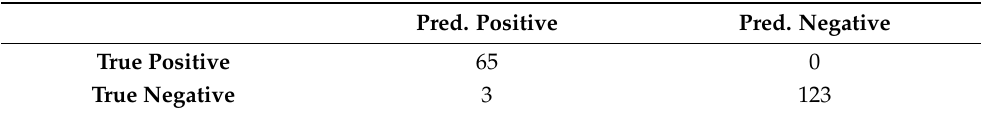
Table 7. Confusion matrix for the testing set without the cases labeled as “Others”: CNN Xception. Pred.